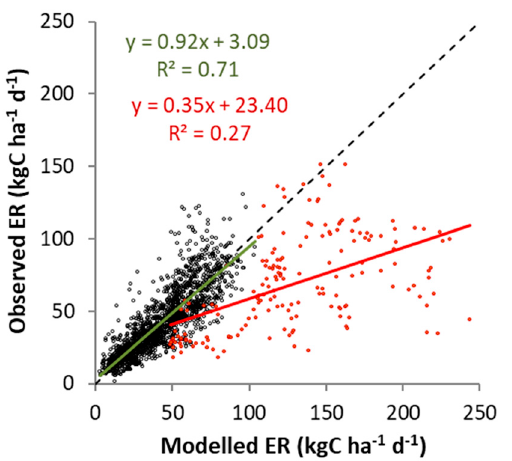
Figure 12. Scatter plot of observed vs modeled ecosystem respiration rates outside grazing periods (black) and during grazing periods (red) for the five years of the study.